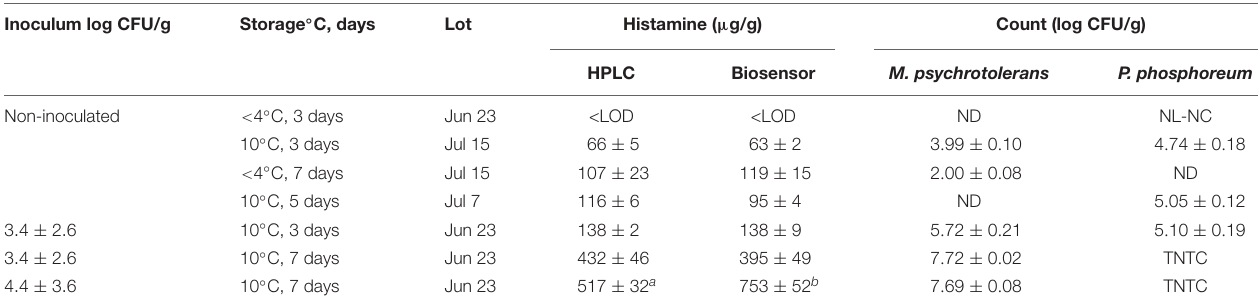
TABLE 4 | Levels of histamine ( µ g/g) and numbers of M. psychrotolerans and P. phosphoreum (mean ± SD) detected in inoculated and non-inoculated tuna samples at different days of storage. Inoculum log